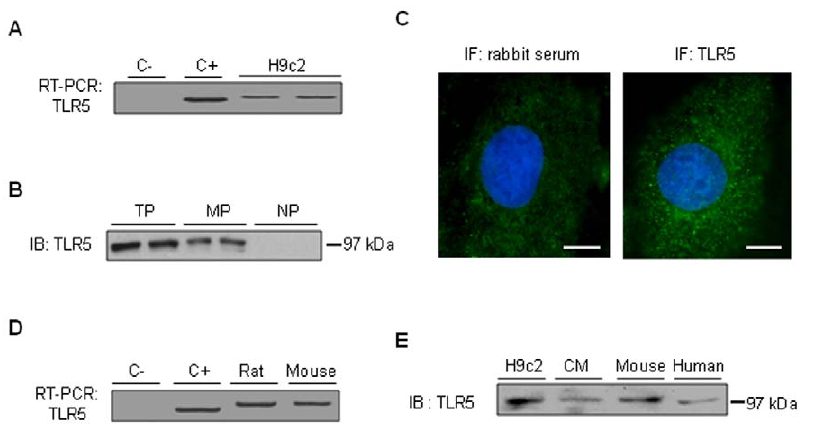
Figure 1. Expression of TLR5 by cultured cardiomyocytes and whole heart tissue. A, RT-PCR analysis of tlr5 transcription on H9c2 total RNA. C-, negative control (no RNA); C + , positive control. Sizes of the amplified fragments: 310 bp (C + ); 381 bp (TLR)5. B, TLR5 protein expression in H9c2 cells. Total proteins (TP), membrane proteins (MP), nuclear proteins (NP). C, Immunofluorescence detected the presence of TLR5 in H9c2 cells. Normal rabbit serum (left) instead of anti-TLR5 antibody for negative control. Scale bar size: 10 m m. D, RT-PCR analysis of tlr5 transcription in rat and mouse heart. E, Constitutive expression of TLR5 protein in H9c2, rat primary ventricular cardiomyocytes (CM), and mouse and human heart.